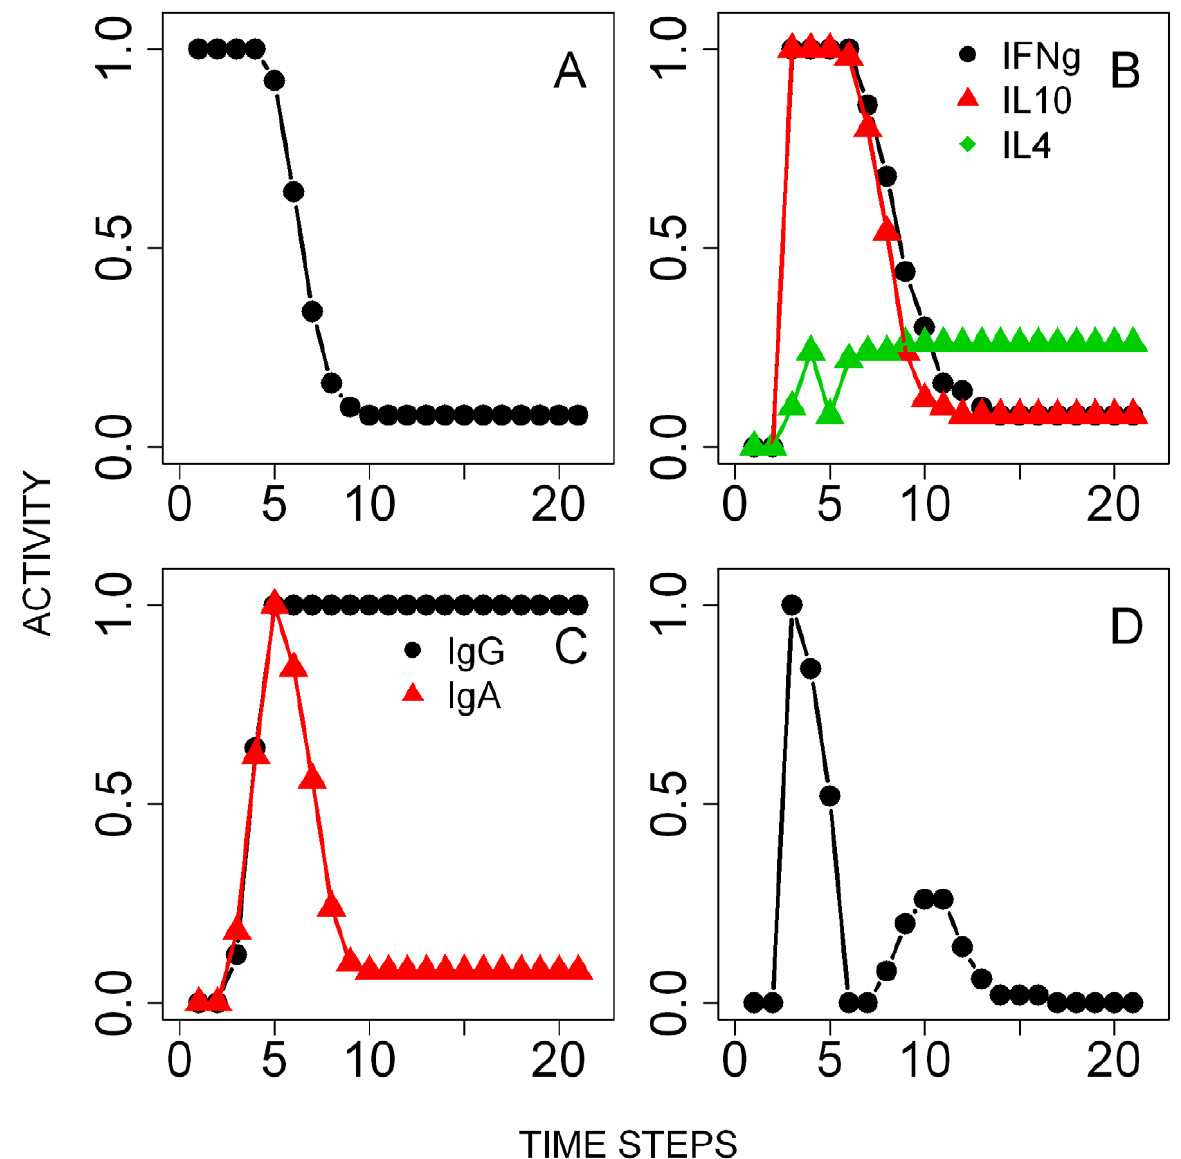
Figure 7. Results of the simulations of the time course of B.bronchiseptica from the co-infection. Activity profiles (the probability of the node being in an ON state at a given time-step) are reported for: A - Bacterial colonies in the lungs. B - Cytokines, IFN c , IL4 and IL10, in the lungs. C - Serum antibodies. D - Peripheral neutrophils.